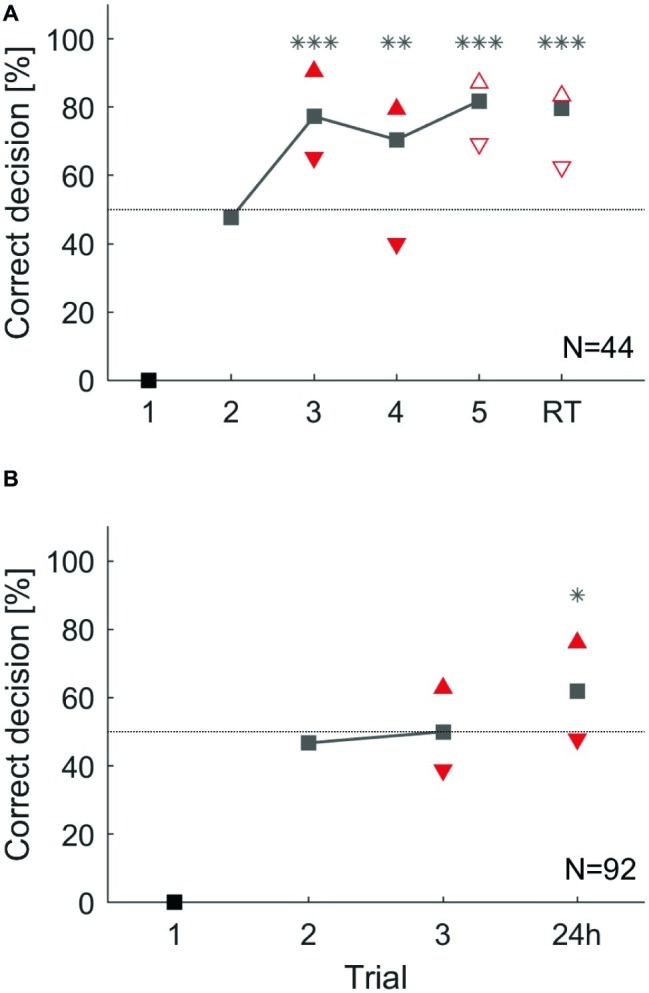
Overall group performance and individual choices during an operant conditioning task in a T-maze (A) over five consecutive trials and a 35 min retention test (RT). From the third trial on cockroaches chose significantly more often the correct direction (**: p < 0.01; ***: p < 0.001). (B) Operant conditioning over three trials and a retention test after 24 h. However, this time cockroaches did not learn during training but chose significantly more the correct direction in the 24 h retention test (*: p < 0.05). Triangles that point upward depict animals that chose the correct direction in two consecutive trials (pC). Triangles that show downward depict animals that chose the correct direction in the present trial but did not choose it in the previous trial (pI). Filled triangles differ significantly from each other within a trial and empty ones do not (χ2; α = 0.05).